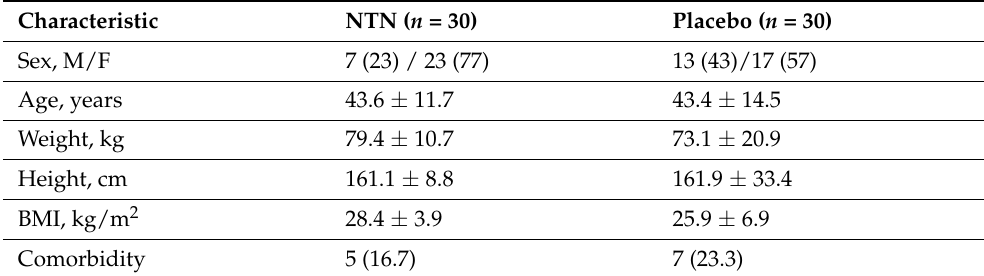
Table 1. Baseline demographic and clinical